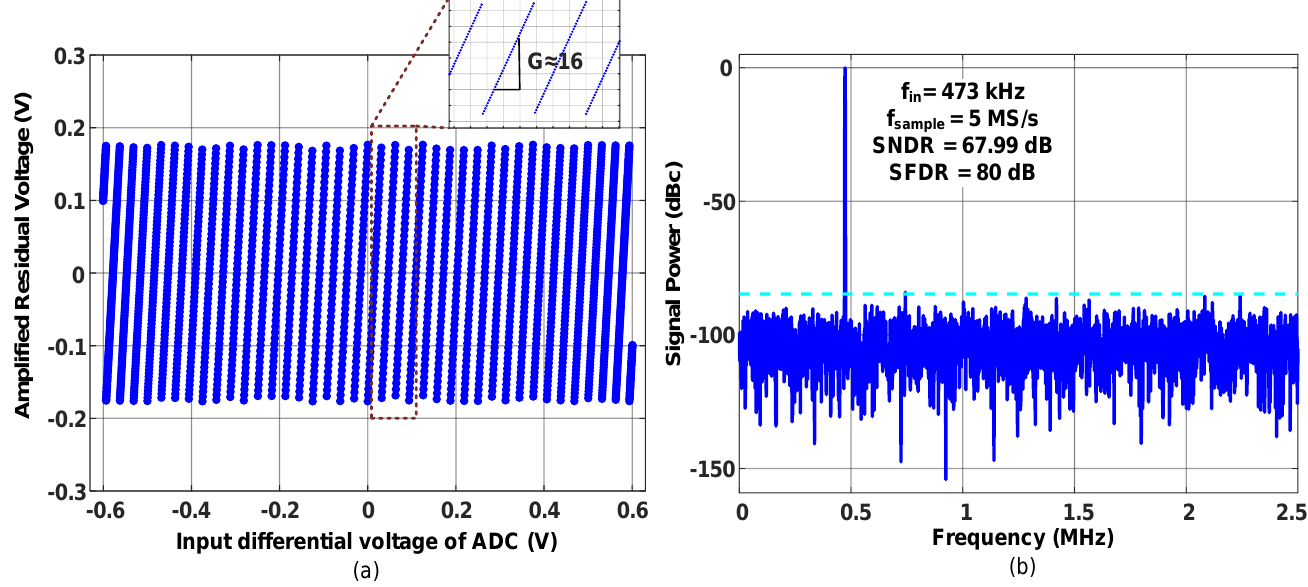
Figure 6. ( a ) The simulated residue transfer function of 2-stage pipelined SAR ADC. ( b ) The simulated ADC spectrum with 473 kHz input when random noise is enabled.